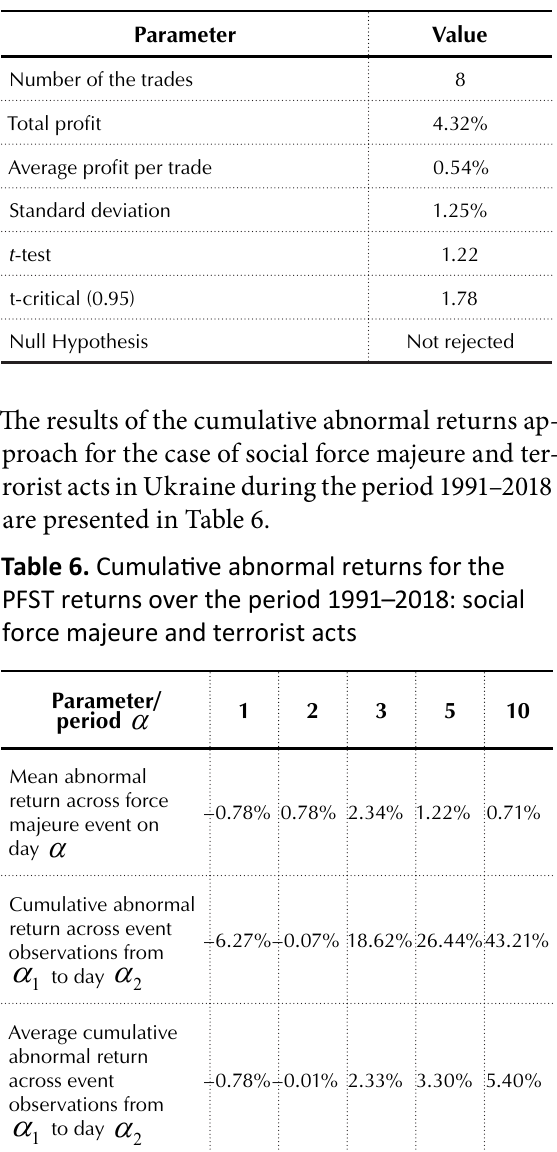
Table 5. T -test for evaluating the success of the